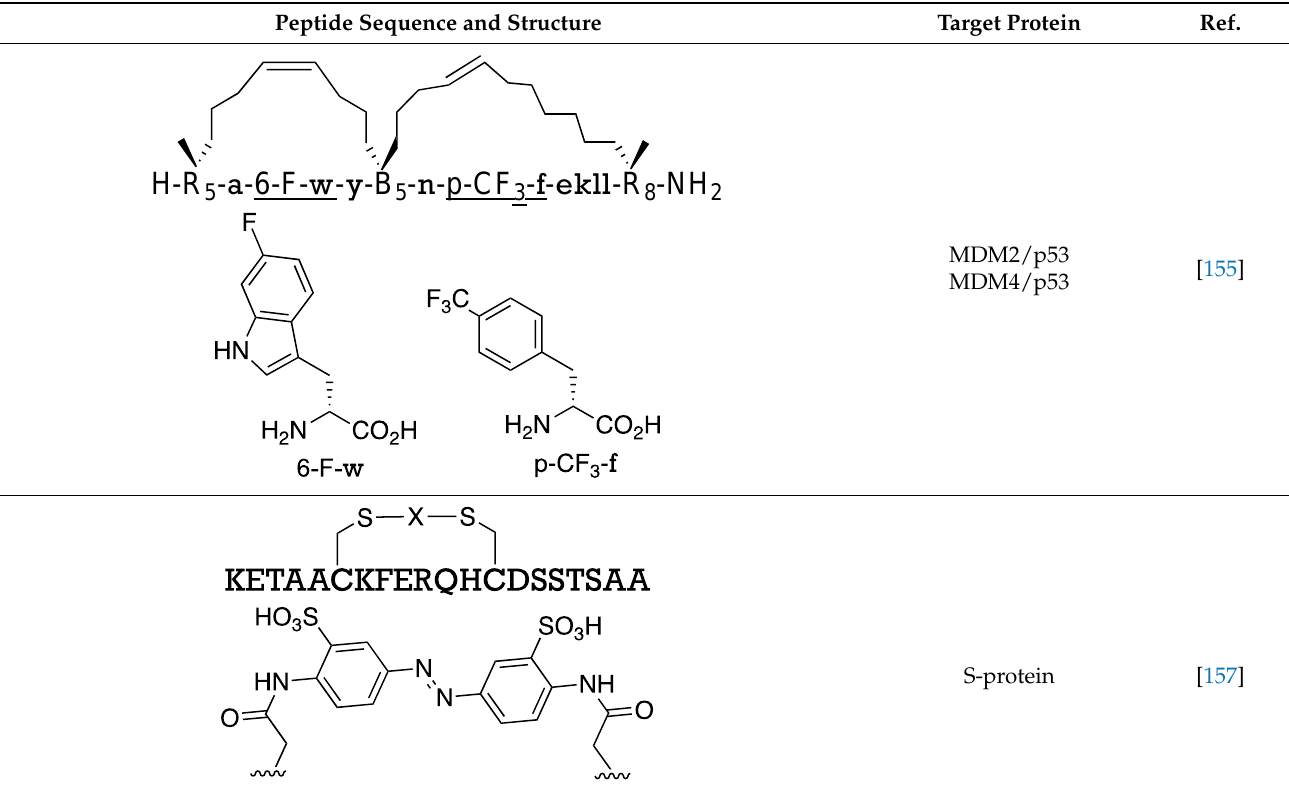
Table 7. Cont. Peptide Sequence and Structure Target Protein